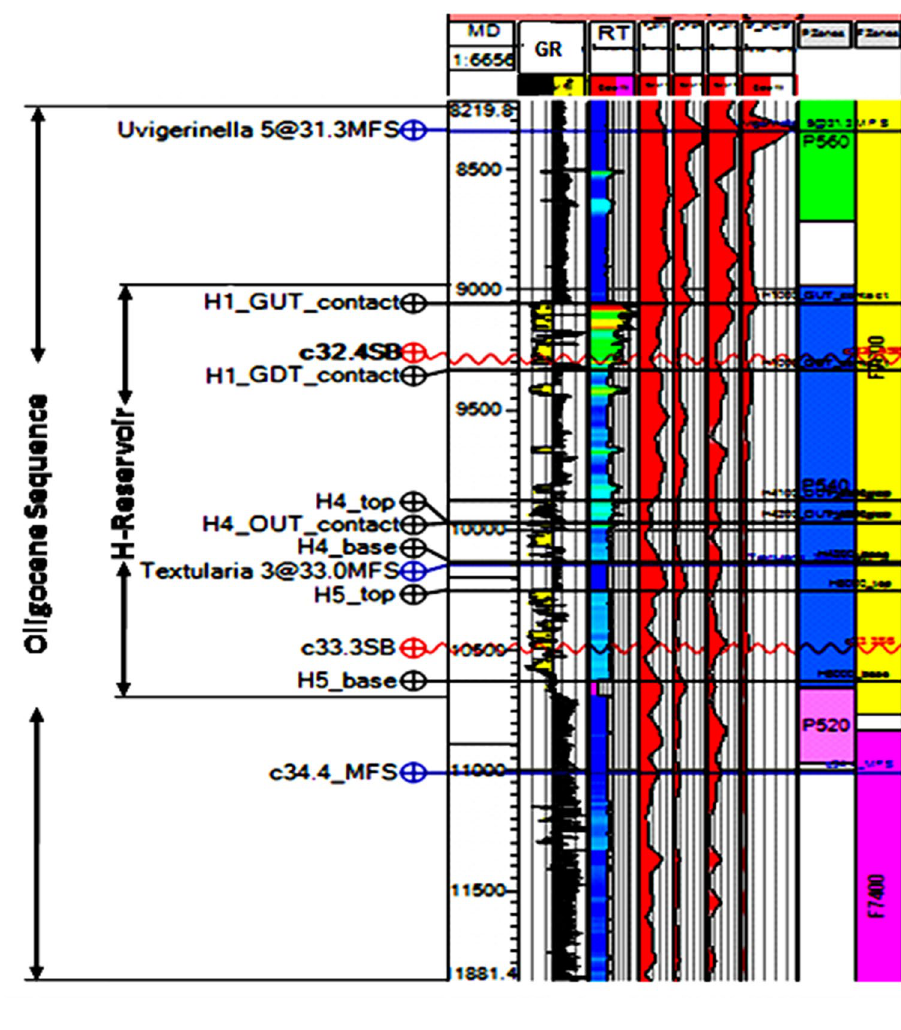
Fig. 3 Lithologic sequence from well A in northern part of the Bumma field. (31.3MFS, 32.4SB, 33.0MFS, 33.3SB, and c34.4_MFS are the maximum flooding surfaces and sequence boundaries defined over the Oligocene sequence)